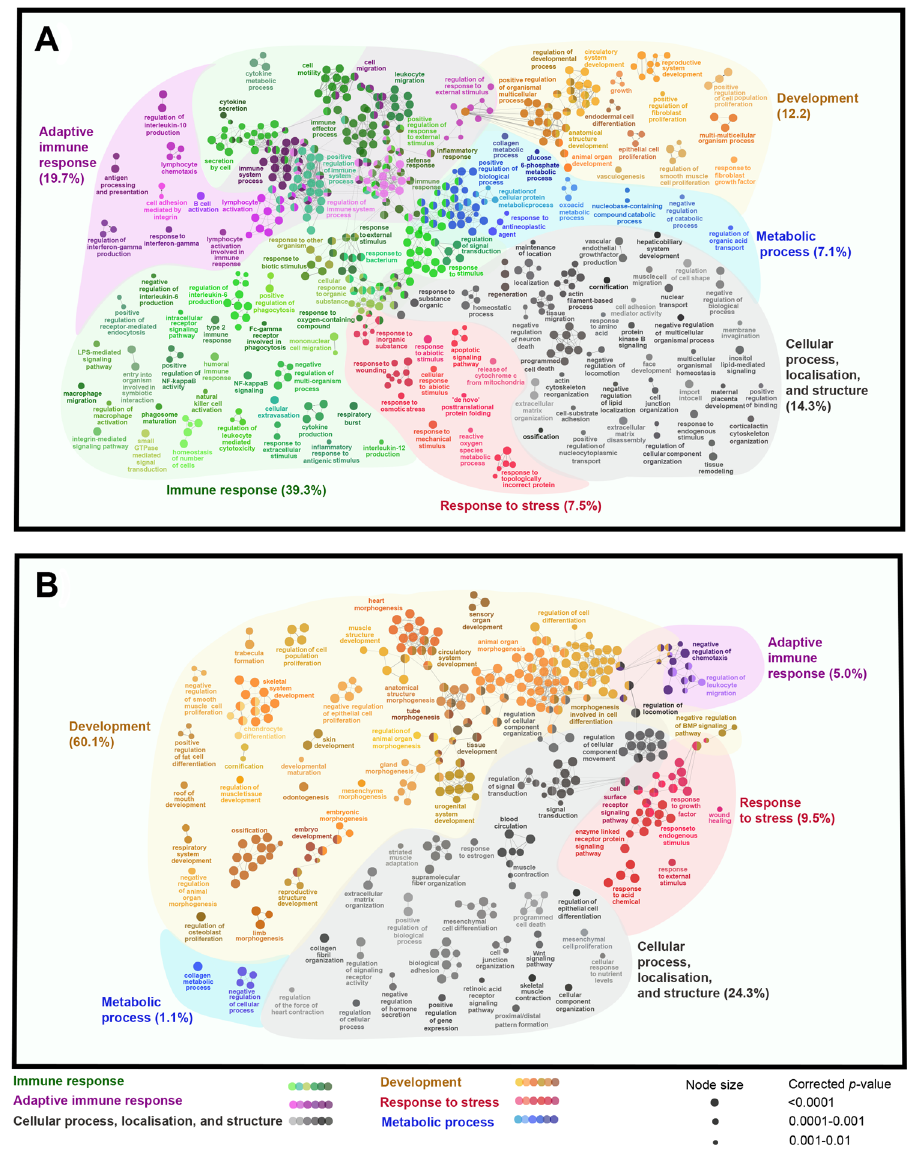
Figure 2. The pathways enriched in M. viscosa -responsive transcripts. Nodes represent Biological Process (BP) GO terms [right-sided hypergeometric test, p values ( p < 0.01) corrected by Benjamini-Hochberg] significantly enriched in transcripts up- ( A ) or down-regulated ( B ) by M. viscosa infection at the lesion site (Mv-At vs. Control; 5212 DETs), compared to the whole RNA-Seq dataset (used as Reference). Nodes are coloured according to the functional theme to which they were assigned. Node size corresponds to different p value ranges (i.e. p < 0.0001, 0.0001–0.001, and 0.001–0.01). Highly related terms (kappa coefficient > 0.4) are connected with grey lines. Individual GO terms (i.e. single node) and GO networks (i.e. multiple connected nodes) are grouped by functional